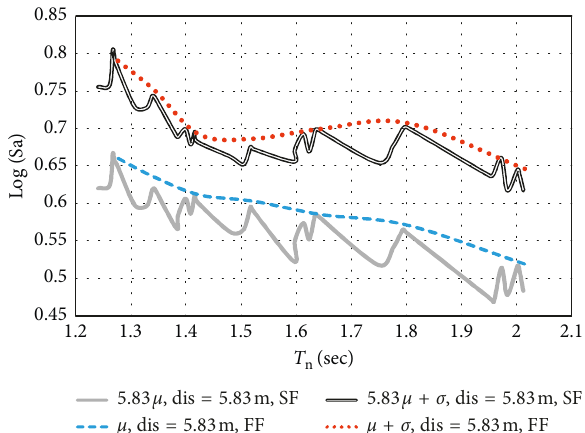
Figure 6: Mean and μ + σ for log of the spectral acceleration for models in the presence (SF) and absence (FF) of a tunnel at a distance of 5.83m from the center of the tunnel projection onto the ground